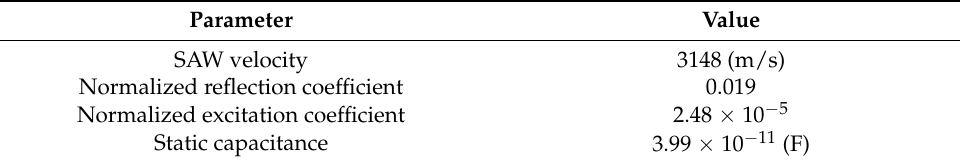
Table 2. COM parameters.